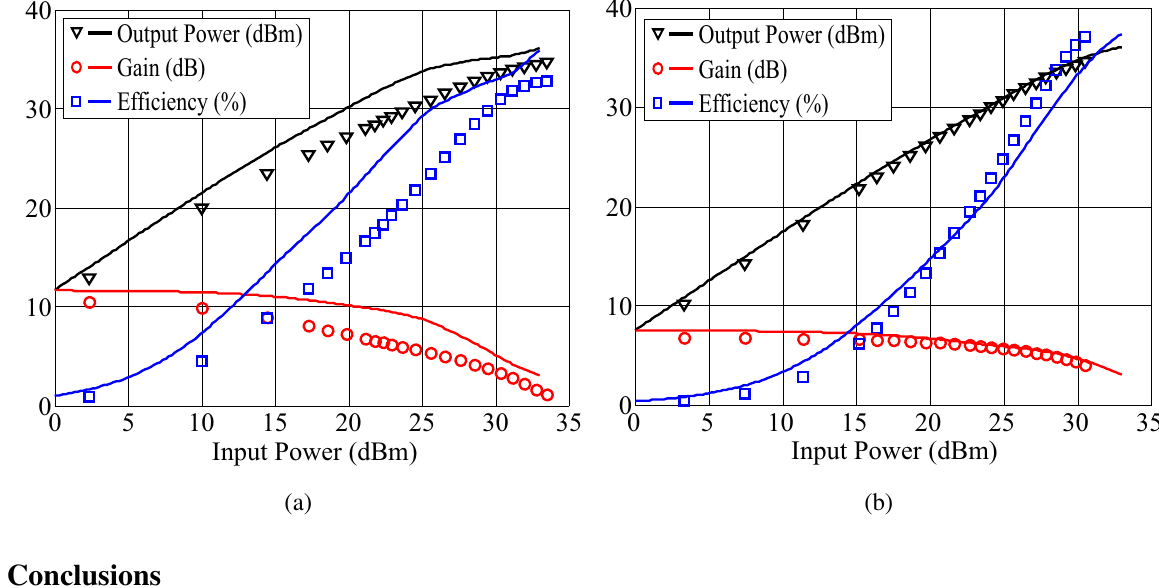
Figure 8. Continuous wave results of the dual-band PA at lower ( a ) and upper ( b ) band. Simulated: solid lines, measured: